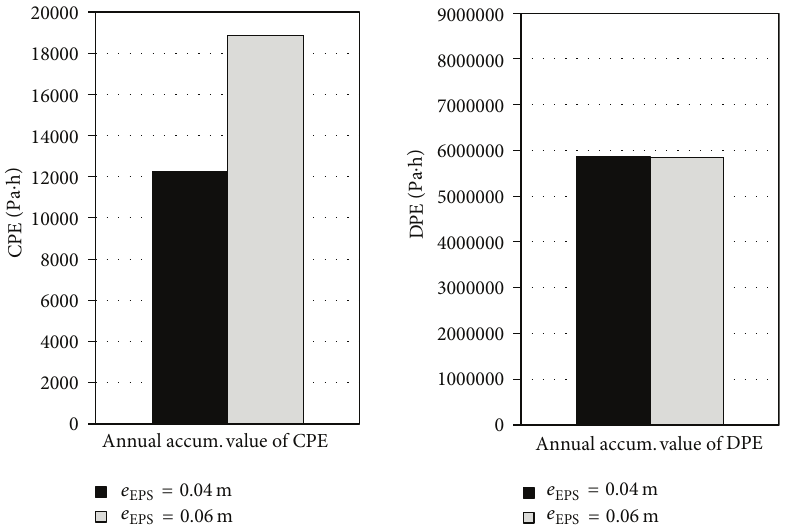
Figure 15: Characteristics of the fac¸ade: total thermal resistance.